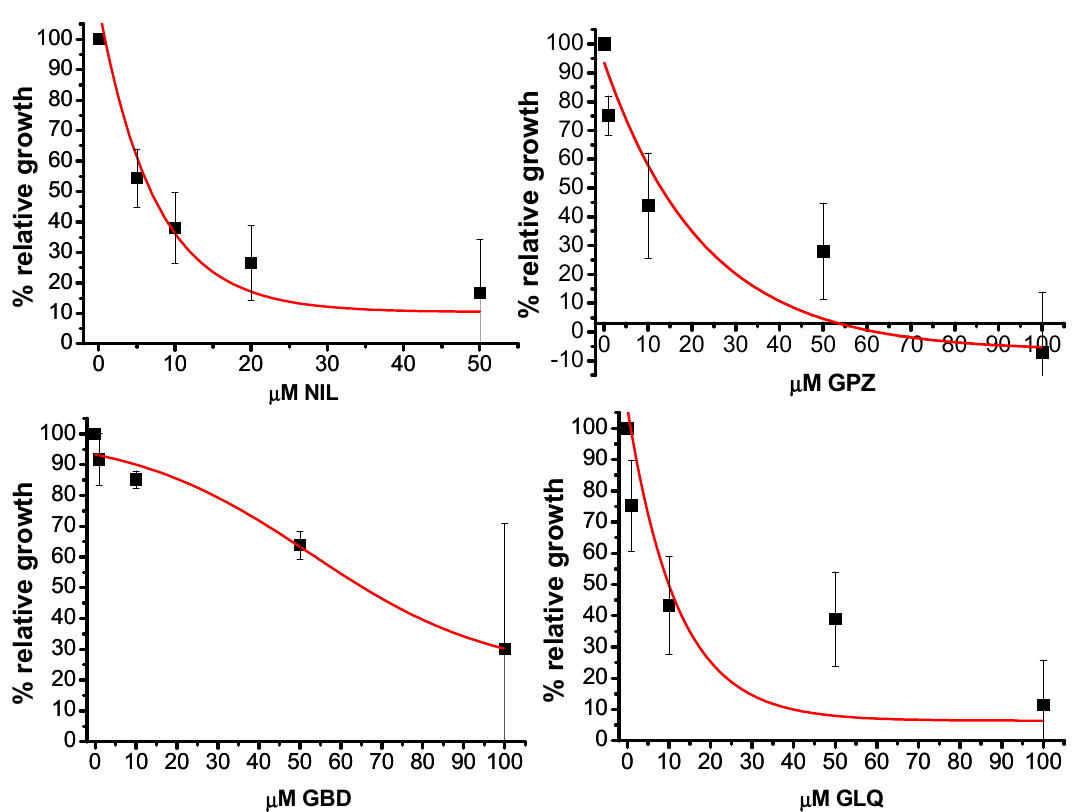
Figure 7. Mean and standard deviation of the e ff ects of nilotinib (NIL), glipizide (GPZ), glyburide (GBD) and gliquidone (GLQ) on the growth of T. cruzi epimastigotes after 24 h.